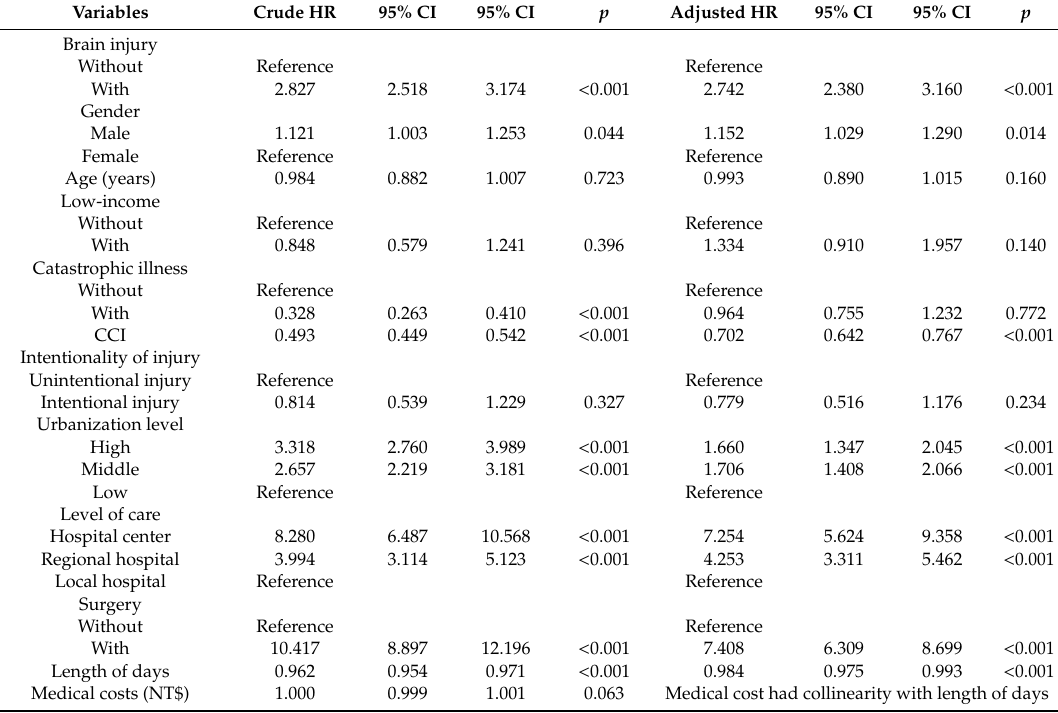
HR = hazard ratio, CI = confidence interval, Adjusted HR: Adjusted variables listed in the table; CCI = Charlson ComorbidityIndex; Unintentionalinjury: ICD-9-CME800-E949; Intentionalinjury: ICD-9-CME950-E979,E990-E999.